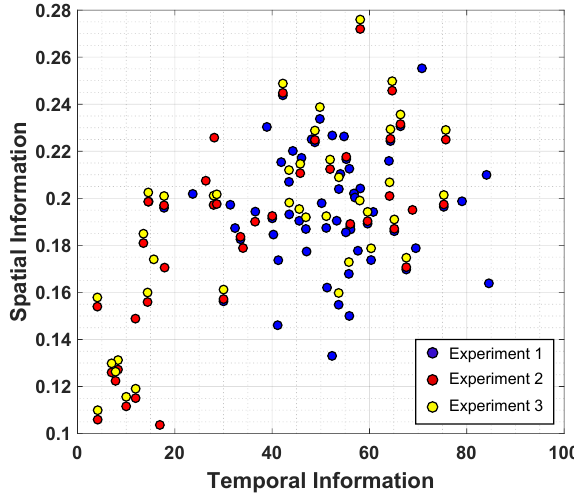
Figure 2. Source videos spatial and temporal information measures.